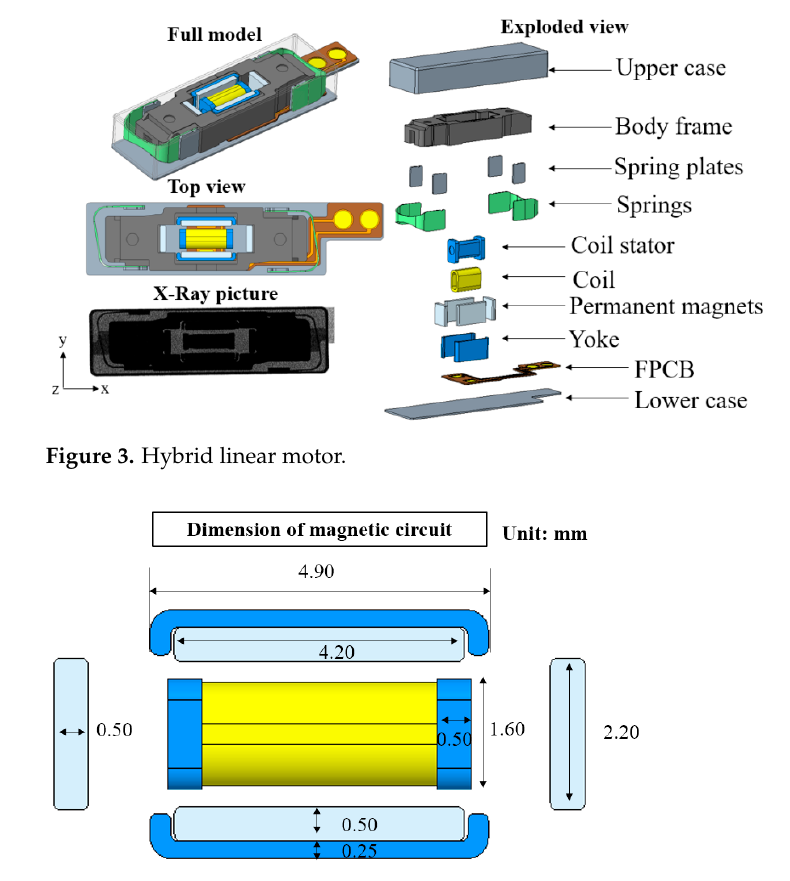
Figure 4. Dimensions of magnetic circuit.